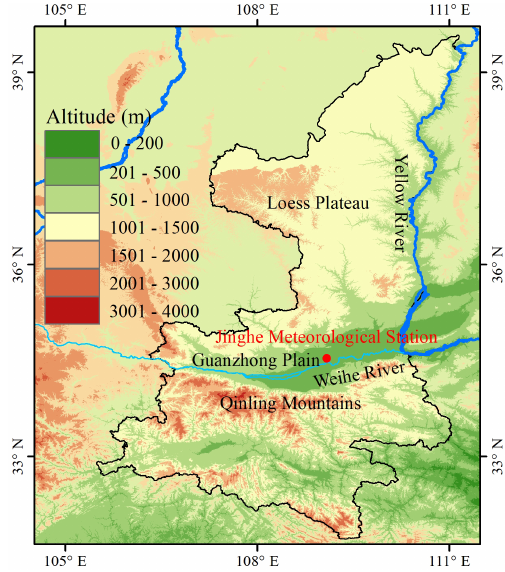
Figure 1. Geographical coverage of Shaanxi Province (31 ◦ 42 (cid:48) – 39 ◦ 35 (cid:48) N, 105 ◦ 29 (cid:48) –111 ◦ 15 (cid:48) E). The red dot indicates the location of the Jinghe National Meteorological Station in Xi’an (33 ◦ 42 (cid:48) – 34 ◦ 45 (cid:48) N, 107 ◦ 40 (cid:48) –109 ◦ 49 (cid:48) E). Table 1. Main parameters of the lidar.